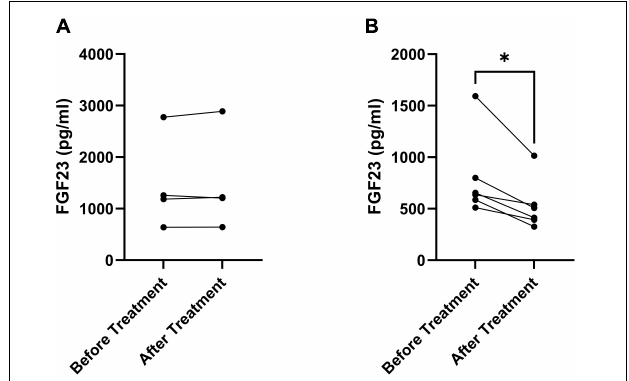
FIGURE 4 | Acute inhibition of aldosterone signaling lowers circulating FGF23 in mice with CKD. Serum levels of circulating intact FGF23 before and 24 h (A) or 72 h (B) after a single iv injection (A) or two sc injections at 0 and 48 h (B) of the mineralocorticoid receptor antagonist canrenone to mice with established CKD, 12 weeks after 5/6-Nx ( n = 4–6 each). * P < 0.05 by Wilcoxon